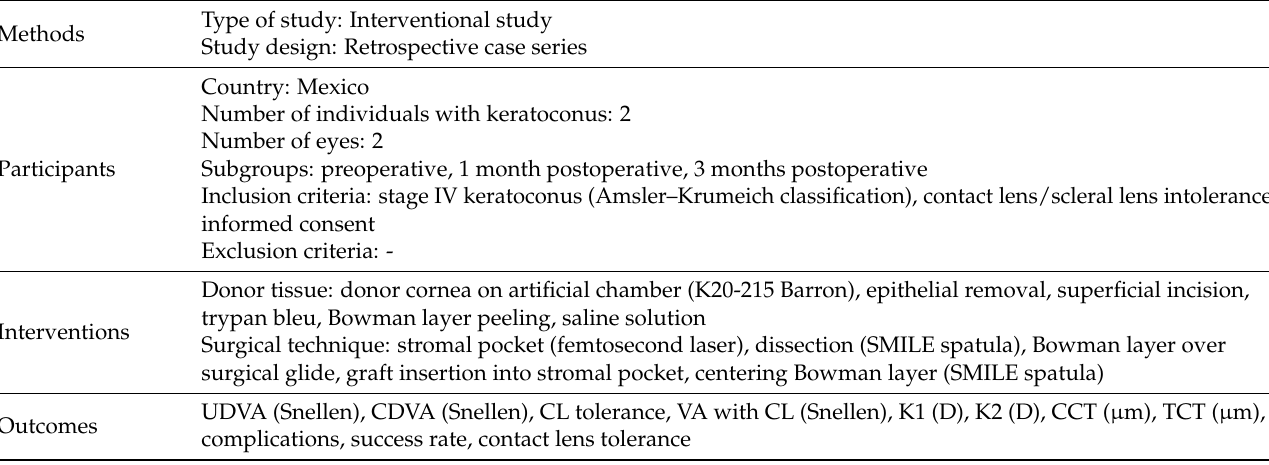
Table A1. Gar í a de Oteyza 2019 [28].